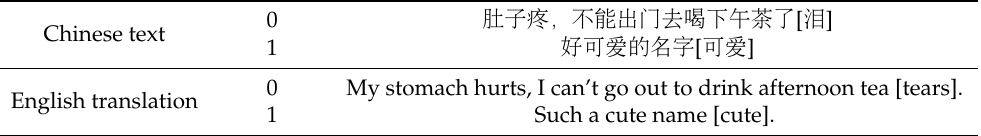
Table 9. Samples and Translation.